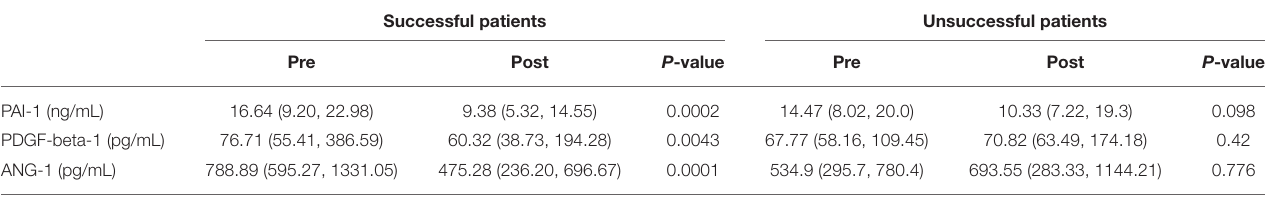
TABLE 6 | Biomarker levels measured by ELISA pre- and post-intervention.